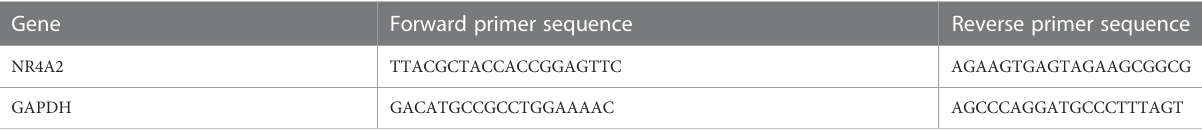
TABLE 2 PCR primers.